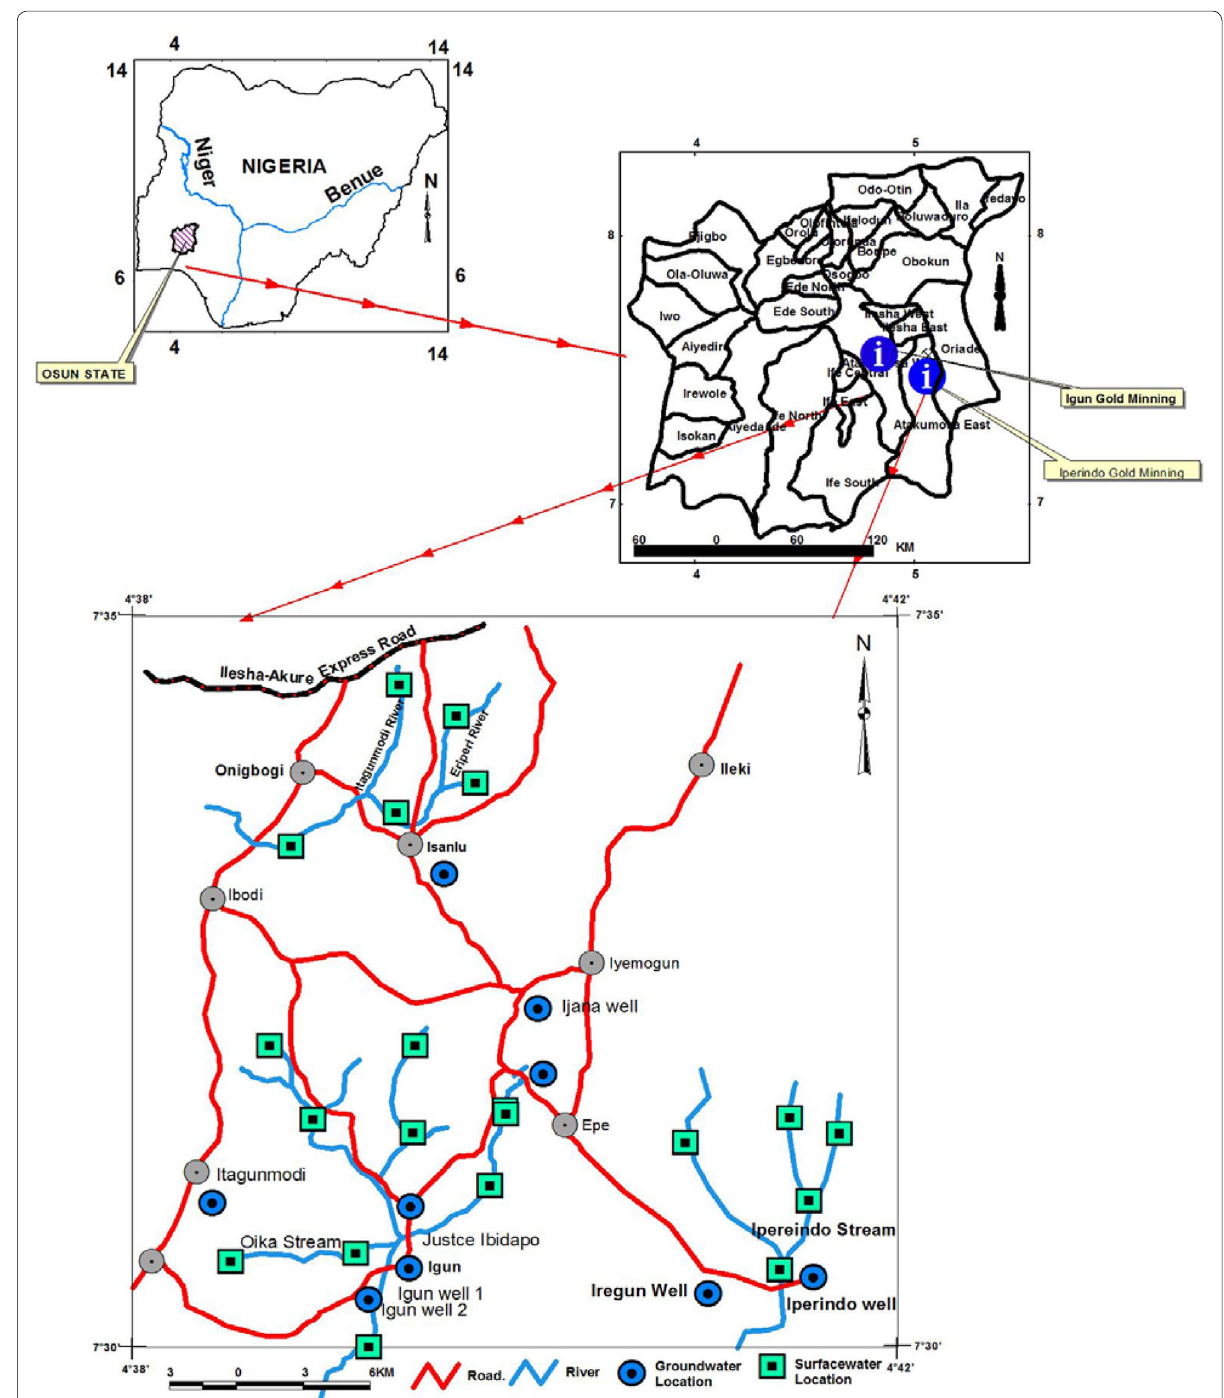
Fig. 1 Map showing the sampling sites in Ijeshaland, Osun State, Southwestern Nigeria (Taiwo and Awomeso